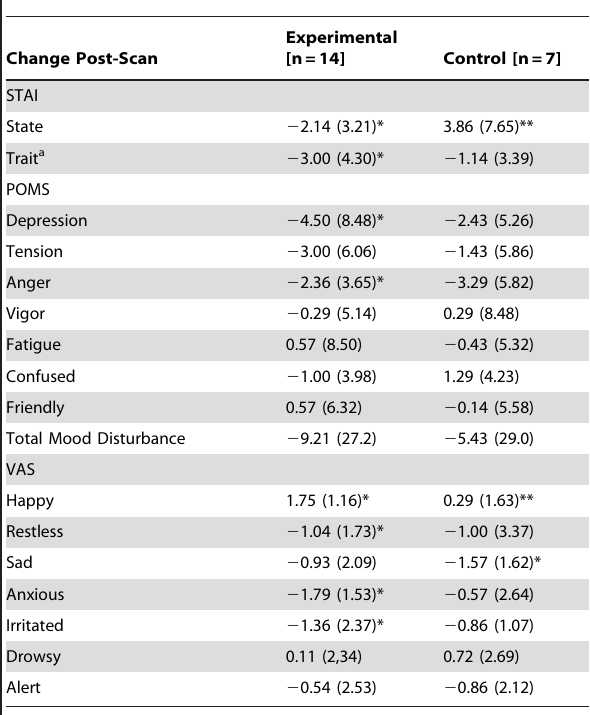
Table 3. Change in mood ratings (post-pre scan scores) following neurofeedback training for each experimental